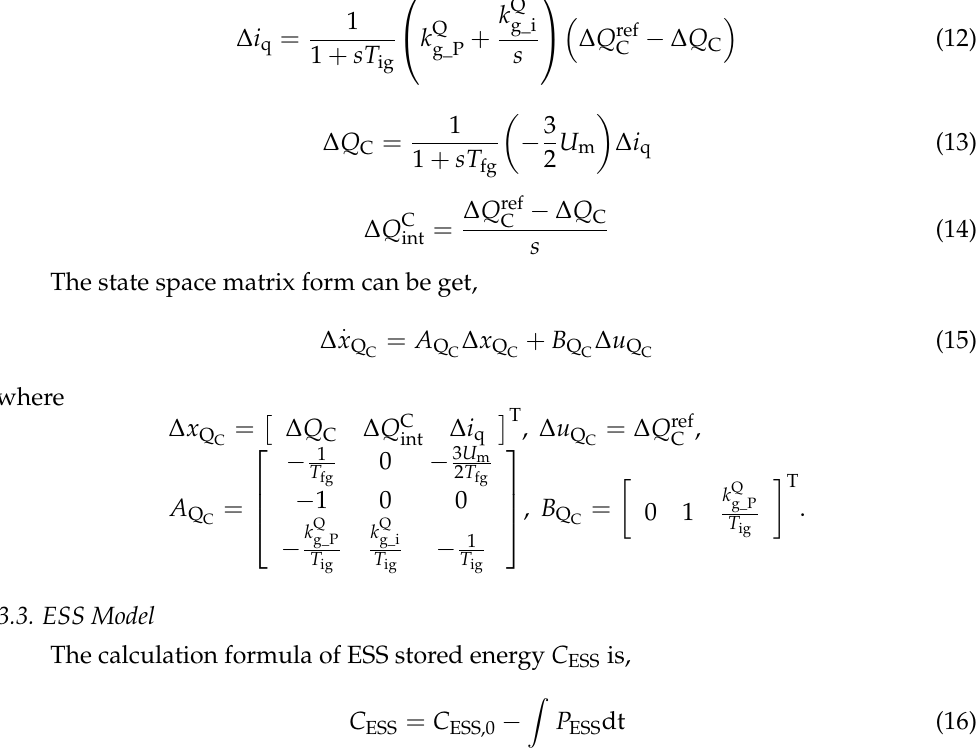
PI controller. U ESS denotes ESU voltage. T id denotes the current loop time constant, T fd